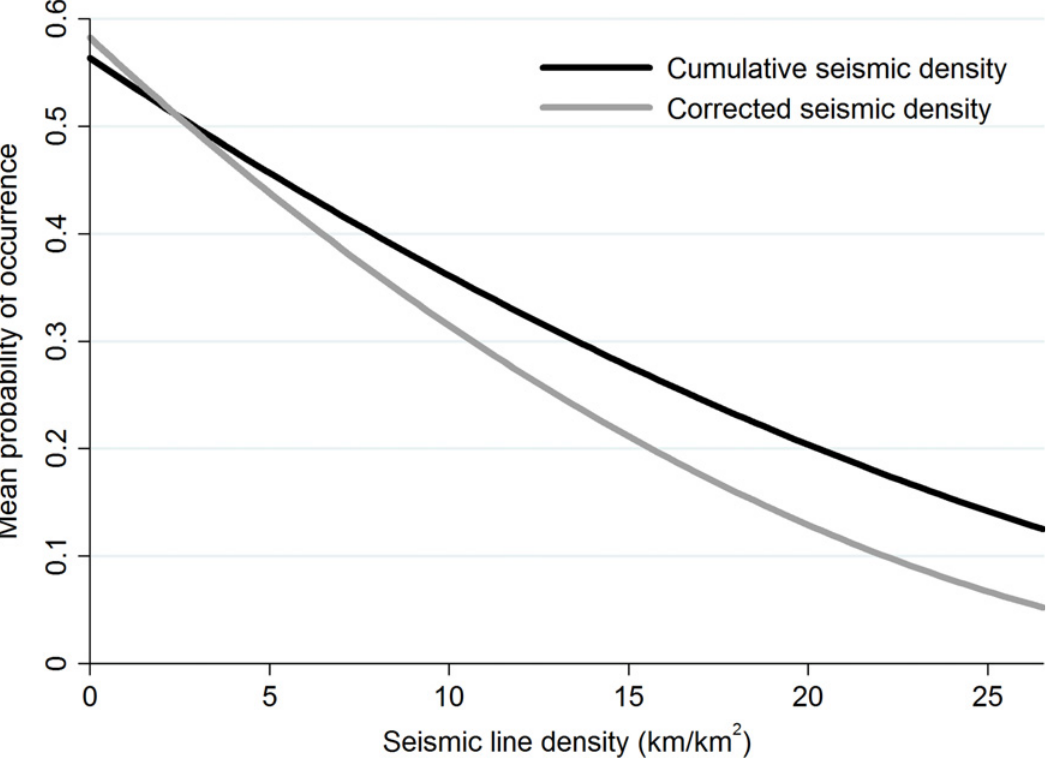
Fig 4. Probability of American marten occurrence is sensitive to seismic line density calculations. The relationship between the probability of American marten ( Martes americana ) occurrence and linear feature density at the home range in northwest Canada is sensitive to line density calculations. Although both metrics of seismic line density show a clear decline, where narrow seismic lines ( (cid:3) 2 m) are removed from the calculation (i.e., corrected seismic density), decline in mean probability of occurrence is almost